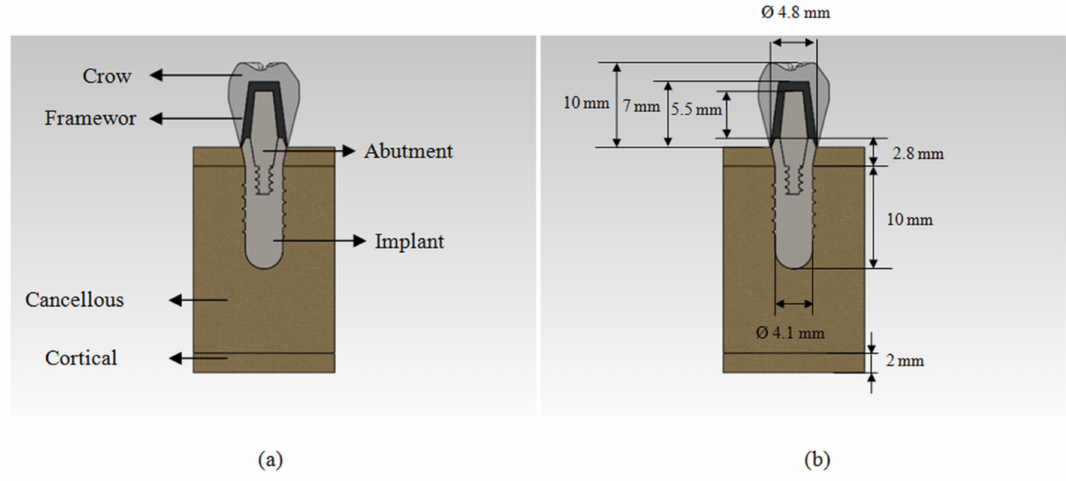
Figure 1. ( a ) Cut view ofthe 3D model of implant, abutment, framework, crown, and bones; ( b ) the dimensions of